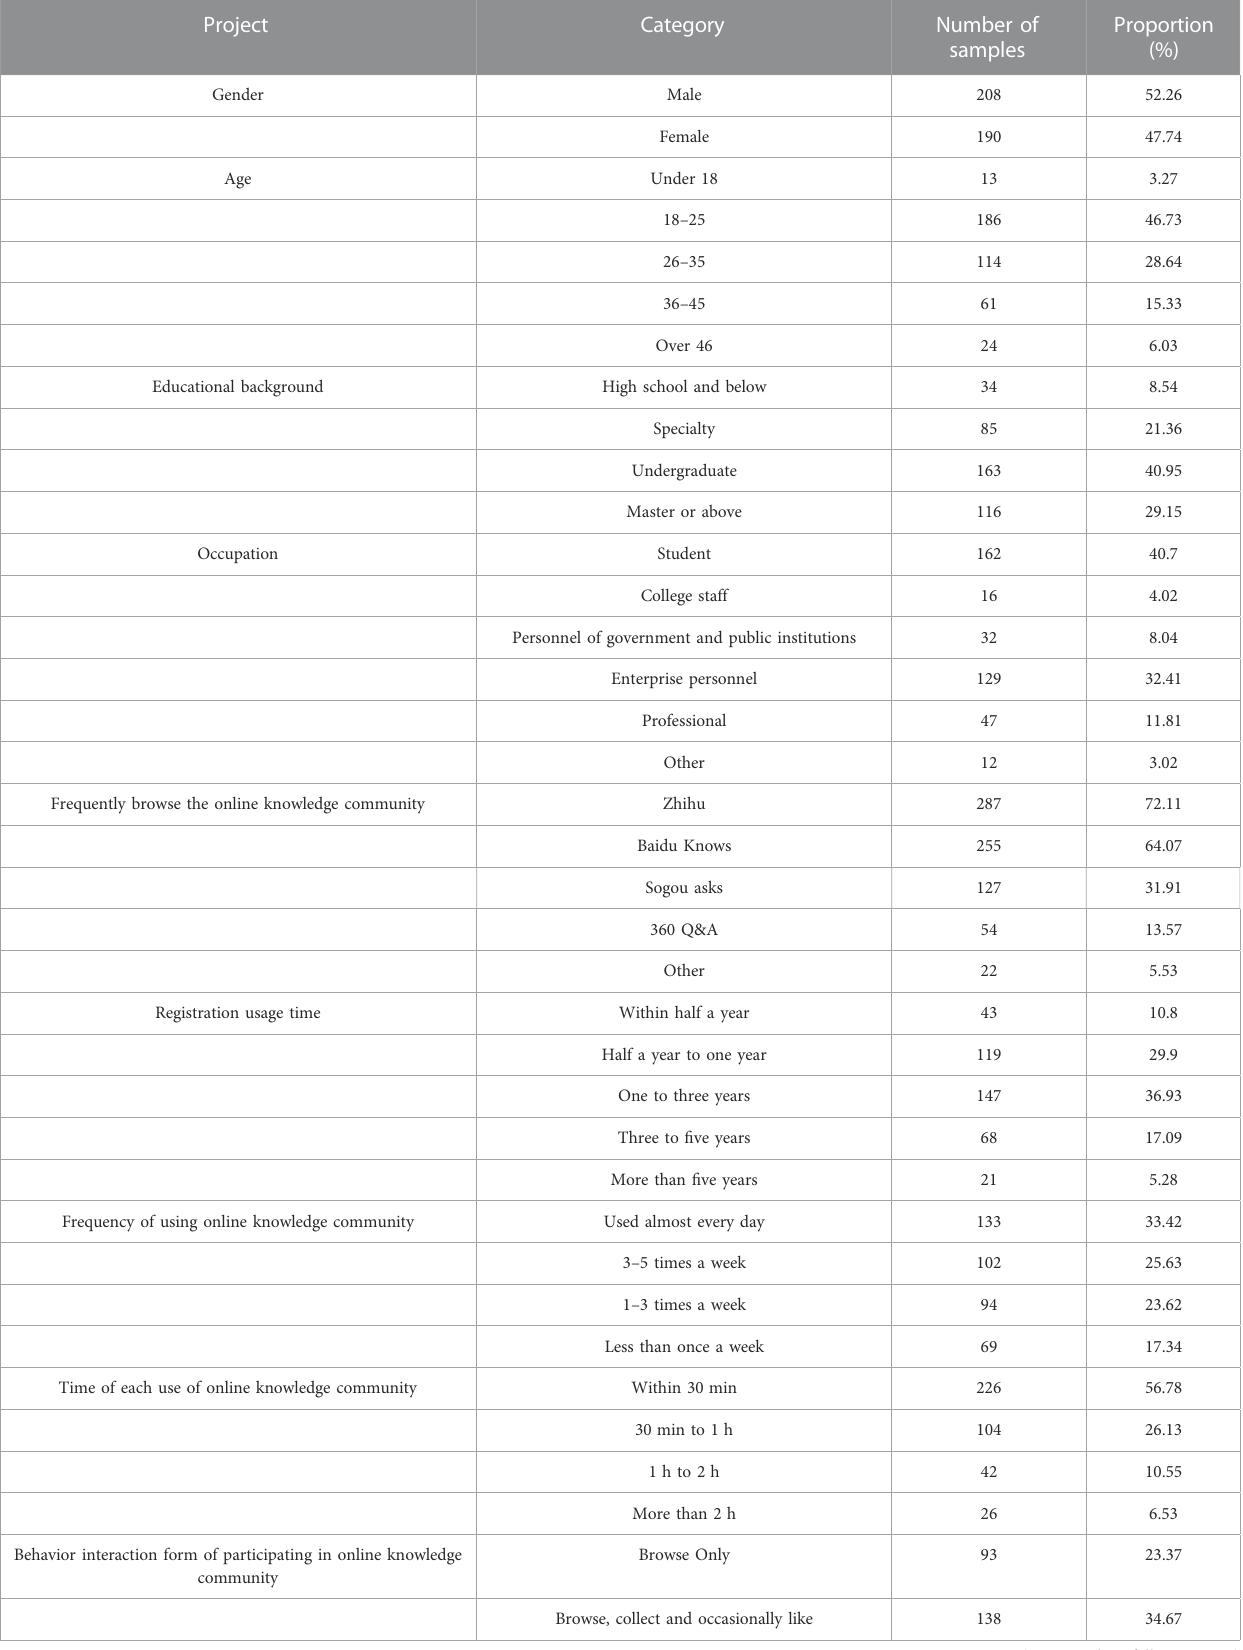
TABLE 4 Sample characteristics of online knowledge community user behavior